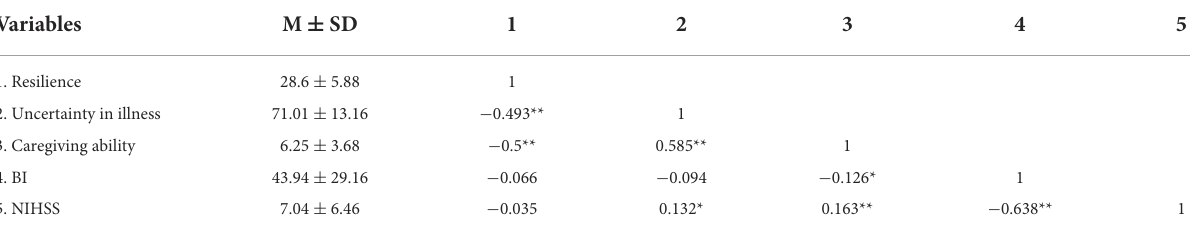
TABLE 2 Correlations matrix of the measured variables.